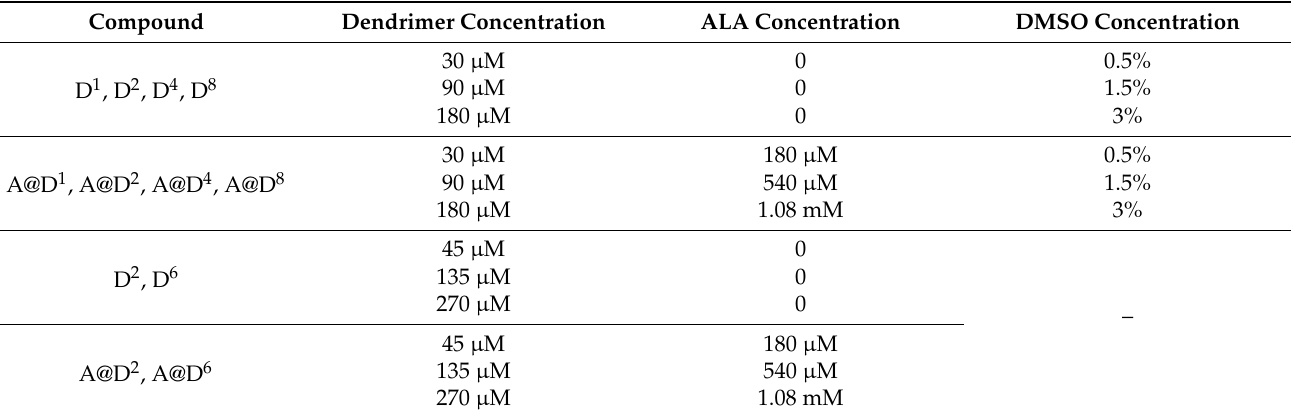
Table 2. Concentrations of dendrimers, ALA, and DMSO in samples used in toxicity studies. Compound Dendrimer Concentration ALA Concentration DMSO